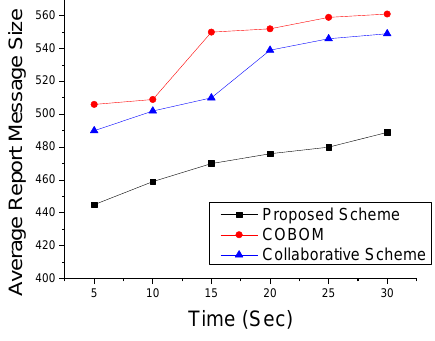
Figure 14. Averaged report message sizes at different times.